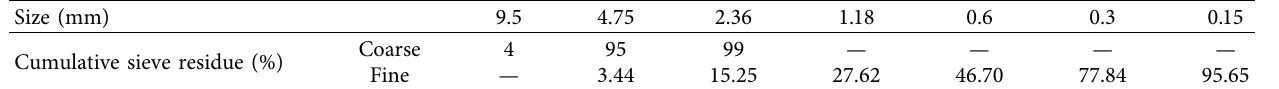
Table 2: Sieving results of coarse and fine aggregates.